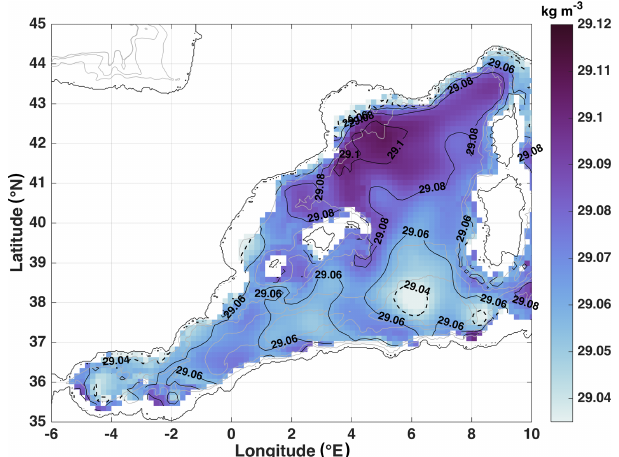
Figure 7. Same as Fig. 6 for the potential density anomaly at 350m, in kgm − 3 . The dashed black contour 29.04kgm − 3 is here to en- hance the particularly remarkable sinking of isopycnals in the east- ern Algerian